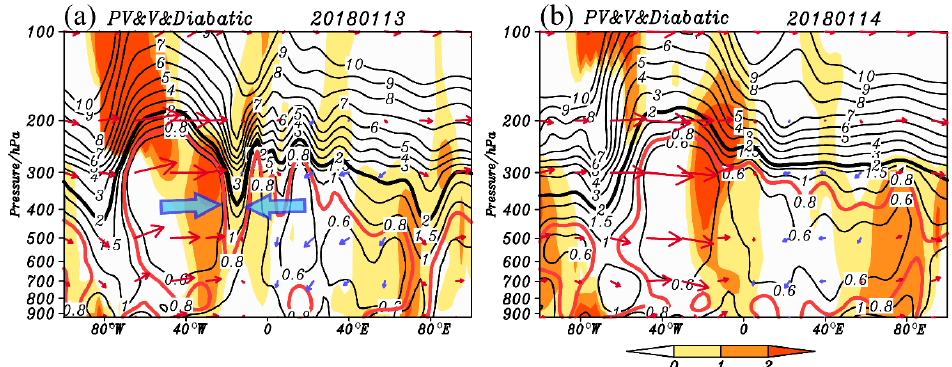
Figure 6. ( a ) Thirteen and ( b ) 14 January 2018, longitude-height profiles of PV (contours), wind (vectors) along latitudes (50–55 ◦ N) and diabatic heating along latitudes (50–60 ◦ N) (shading, units: K day − 1 ). The red thick solid contours are 0.8 PVU. The black thick solid contours are 2 PVU. The arrows are vector wind field from composites of the zonal wind (units: m s − 1 ) and the vertical velocity of p-coordinate system (units: − 100 × Pa s − 1 ): blue indicates easterly and red indicates